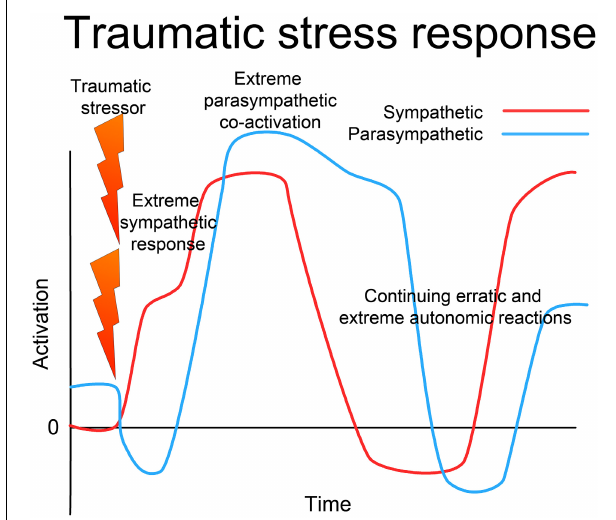
FIGURE 5 | Traumatic stress response. In the face of extreme challenge, when either the situation is extremely threatening and overwhelms the capacity of the organism to respond effectively, or if the response is prevented in some way (restraint), there is first an extreme sympathetic (ergotropic) activation with loss of vagal tone. With continued challenge, there is a sudden intense co-activation of the parasympathetic (dorsal vagal) system along with the sympathetic, leading to freeze, collapse or dissociation. The ANS (and whole CRN) becomes locked into a dysfunctional state of extremely high activation of both the sympathetic and parasympathetic systems, and may oscillate erratically between extremes. This may manifest as alternating depressive shutdown and extreme anxiety or rage. This is not the result of wear and tear, but is a specific dysfunctional state of operation of the complex dynamical system, which through appropriate intervention can be returned to normal resilient